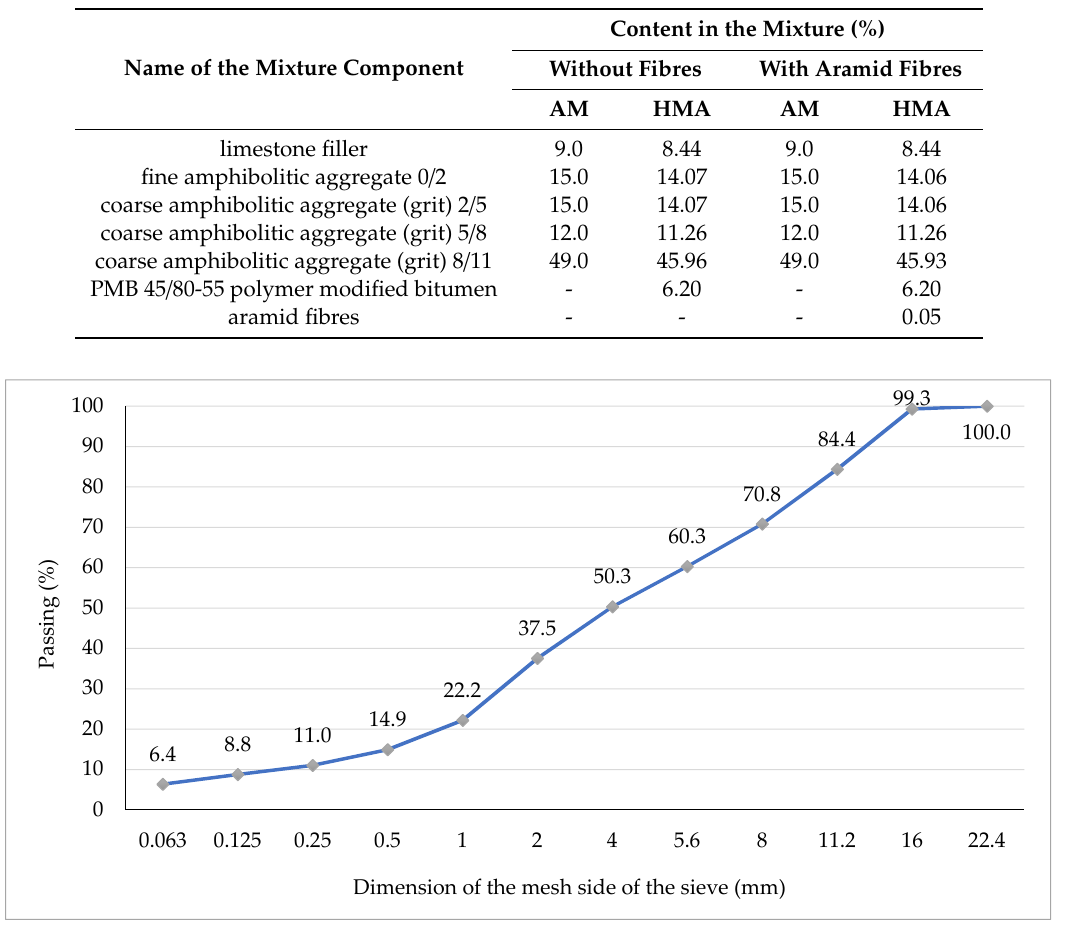
Table 3. Content of components of the SMA 11 mixture with and without aramid fibres.